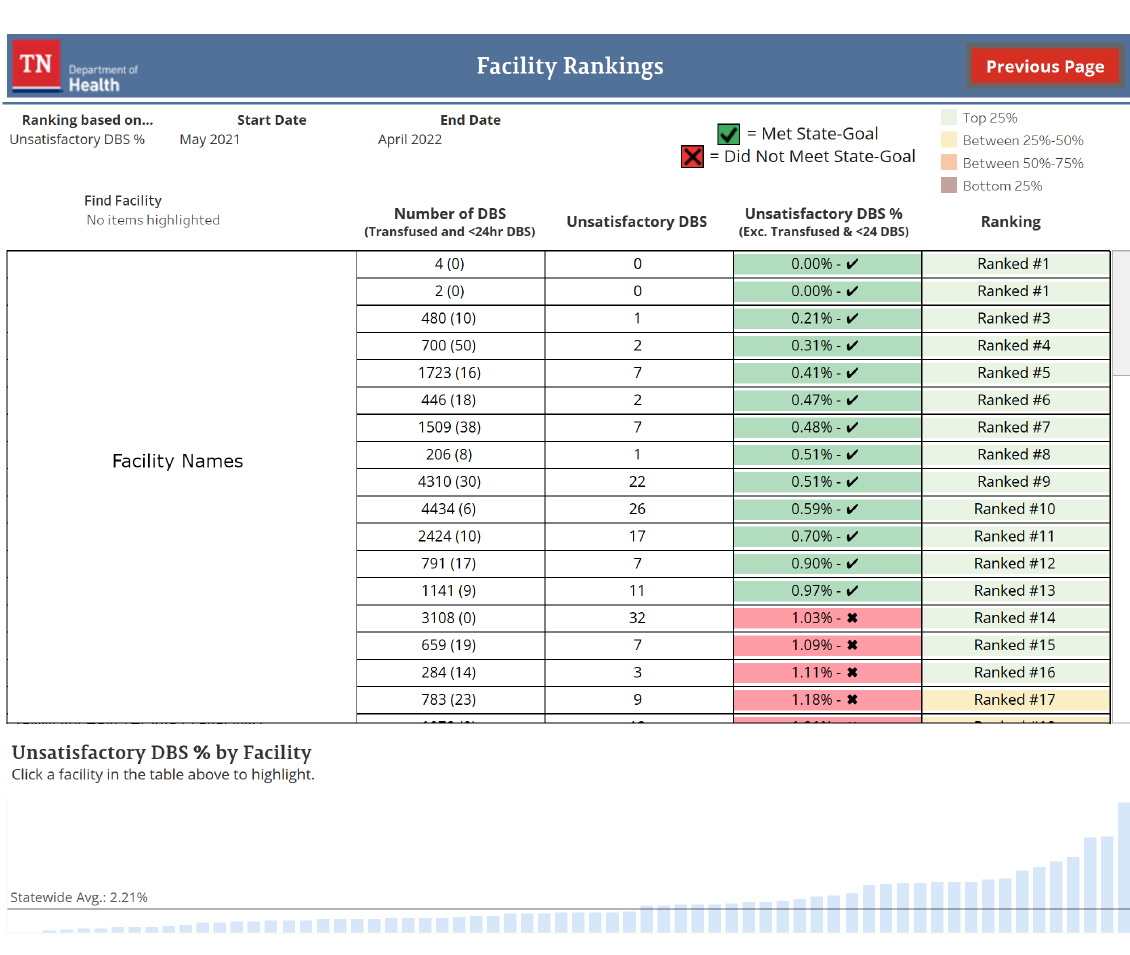
Figure 5. Dried blood spot (DBS). The default view of the dashboard’s facility rankings as of June 2022. Facilities are ranked by a user-selected indicator and displayed in a table and bar chart. Relevant information for the selected indicator is also displayed. Facility names in this figure have been anonymized for use in this